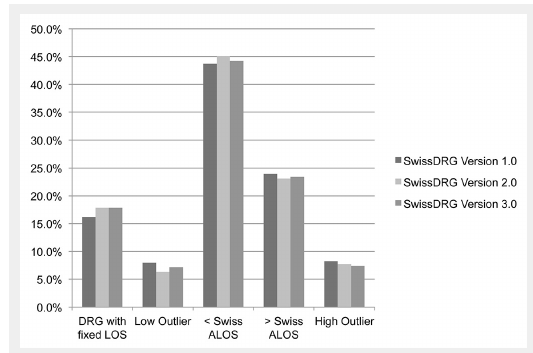
Proportions of DRG inliers (< Swiss ALOS and > Swiss ALOS), DRGs with fixed LOS and outliers (low and high outlier) according to length of stay and definition of low and high trim points for outlier under SwissDRG Versions 1.0, 2.0 and 3.0 respectively. ALOS = average length of stay; LOS = length of